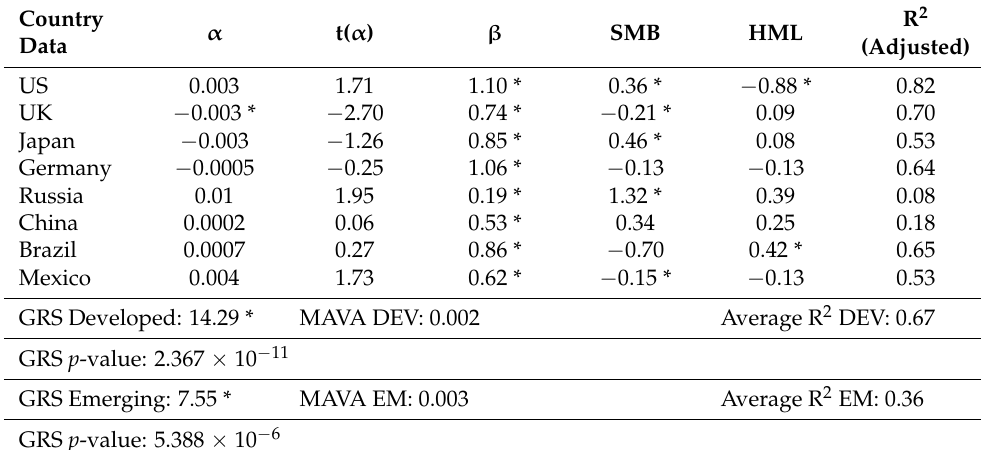
Table 2. Fama French three-factor regressions for country indices—developed and emerging; * p <